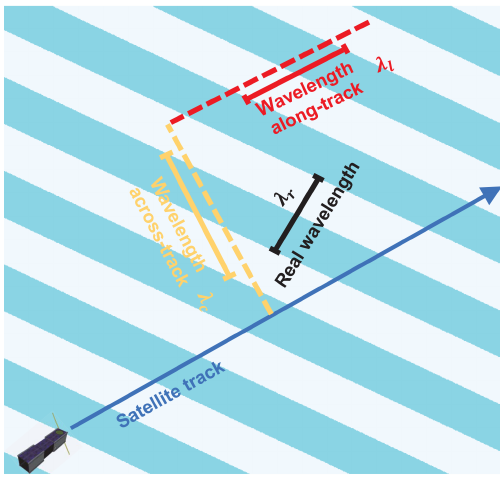
Figure 14. Schematic drawing of observed horizontal wavelength in the sweep-mode observation. The wave fronts of the GW are in- dicated by the light-blue shading. The satellite track is represented by the dark-blue arrow. The retrieved horizontal wavelengths in the along- and across-track directions are represented by yellow and red bars, respectively. The real horizontal wavelength is represented by the black